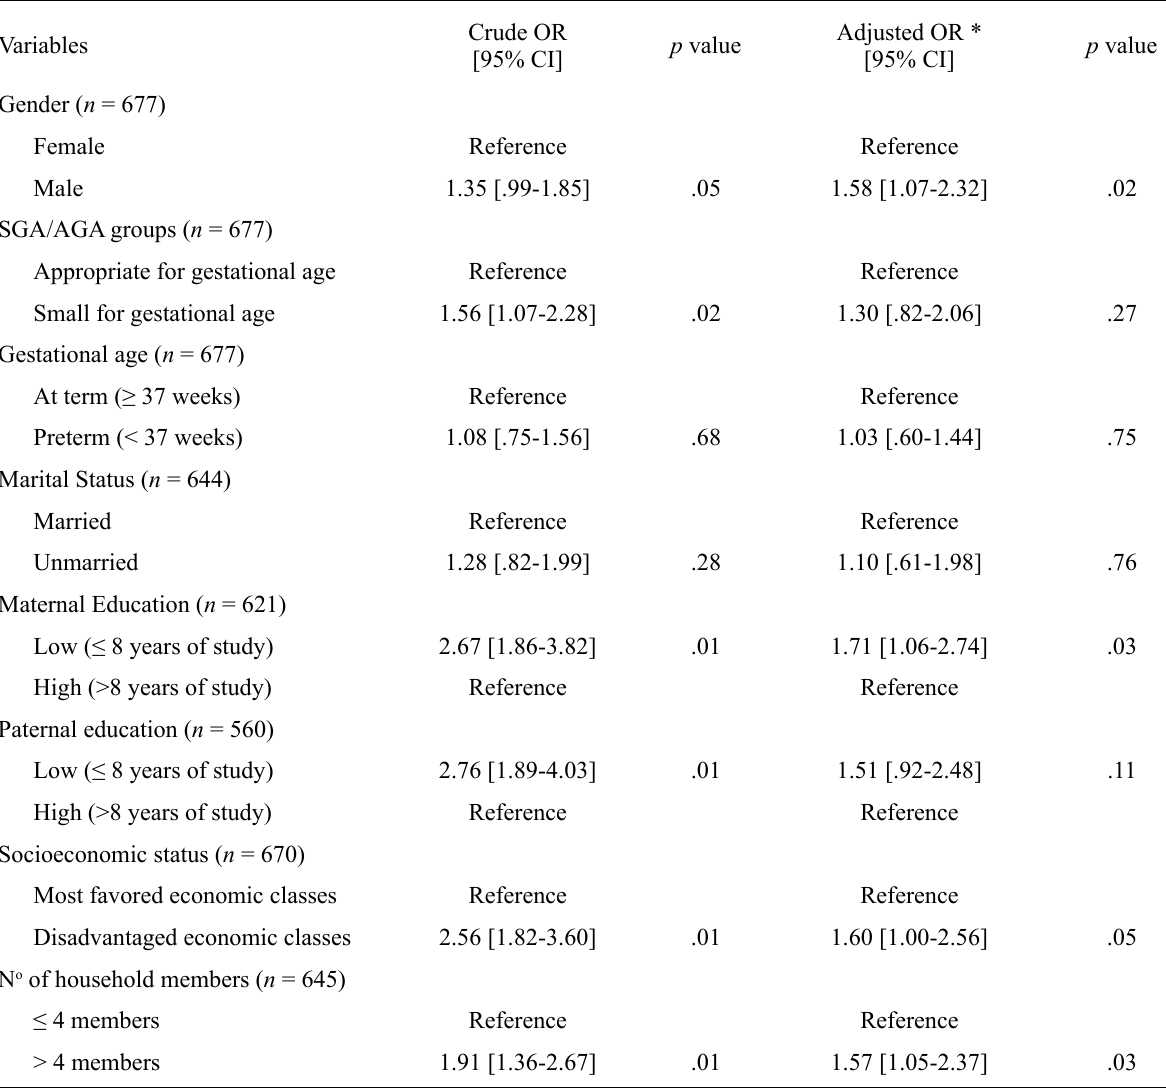
Univariable and Multivariable Binary Logistic Regression for Identifying Associations between Child/Family Characteristics and Mental Health Problems (abnormal range) on SDQ Total Dif fi culties